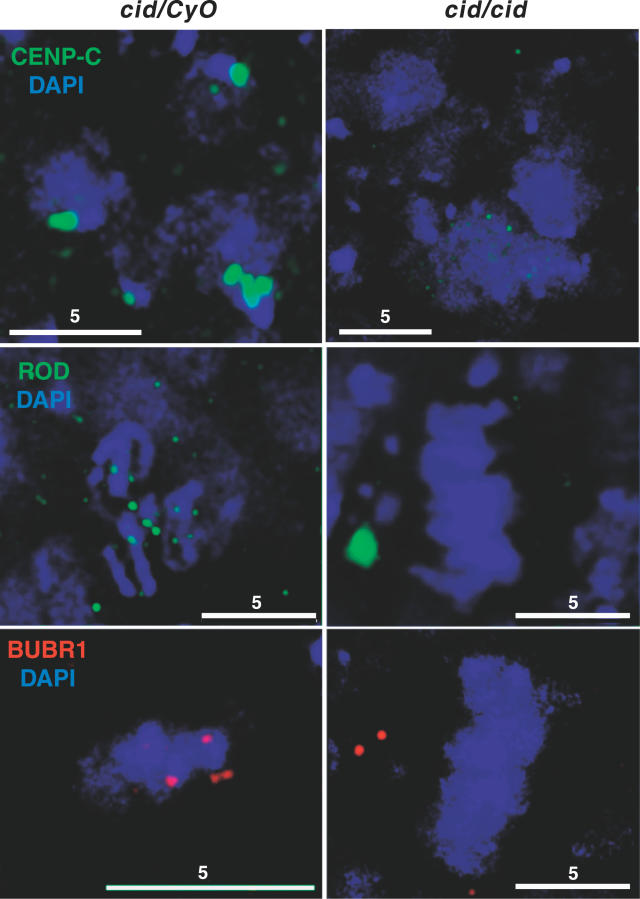
Inner and Outer Kinetochore Protein Localizations Are Disrupted in cid Mutant EmbryosKinetochore localization of CENP-C, ROD, and BUBR1 were determined in stage 15 embryos. In cid/CyO control embryos (left), all three proteins were localized to the centromere/kinetochore during interphase (CENP-C) or the early stages of mitosis (ROD and BUBR1). All three proteins were absent from centromeres/kinetochores in cid/cid animals (right); in some cases, CENP-C was mislocalized in a diffuse pattern. Scale bars indicate 5 μm.